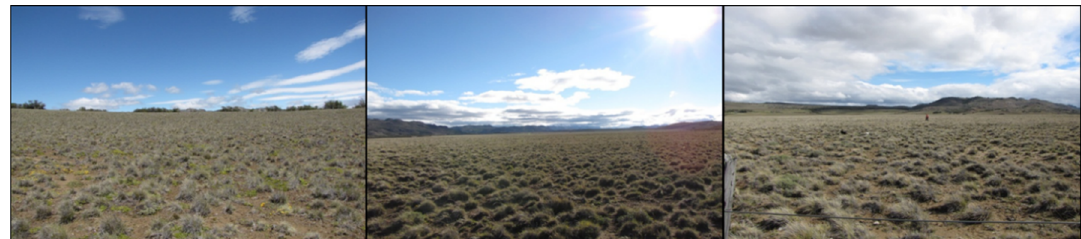
Figure 4. Photographs of the three sites at the Patagonian Steppe, where Pinus contorta survival and establishment experiments were established. They were located at 1.6, 3.5 and 4.7 km from the plantation, approximately.